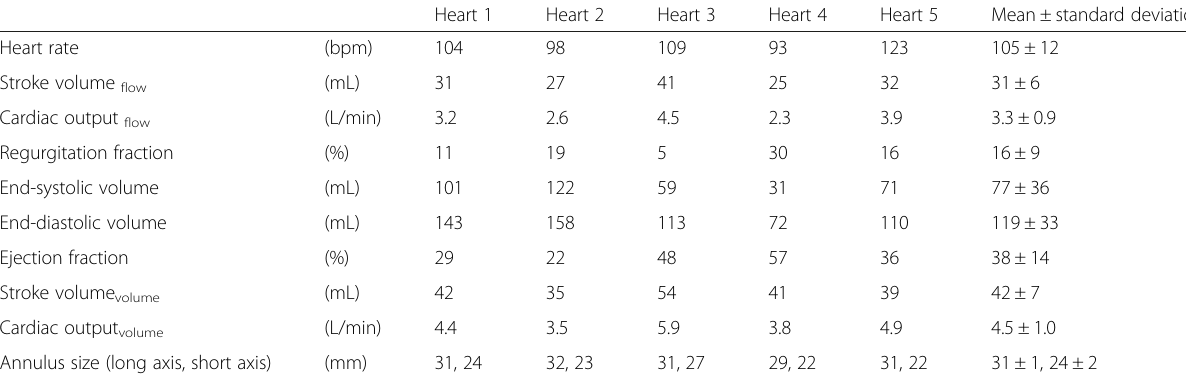
Table 1 Cardiac parameters for the five